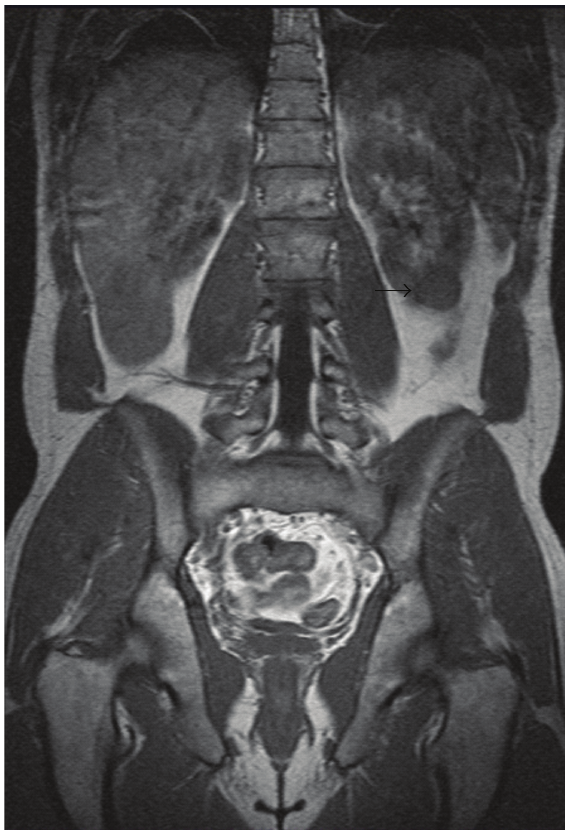
Figure 2: Coronal magnetic resonance imaging scan demonstrating 22mm retroperitoneal lymph node